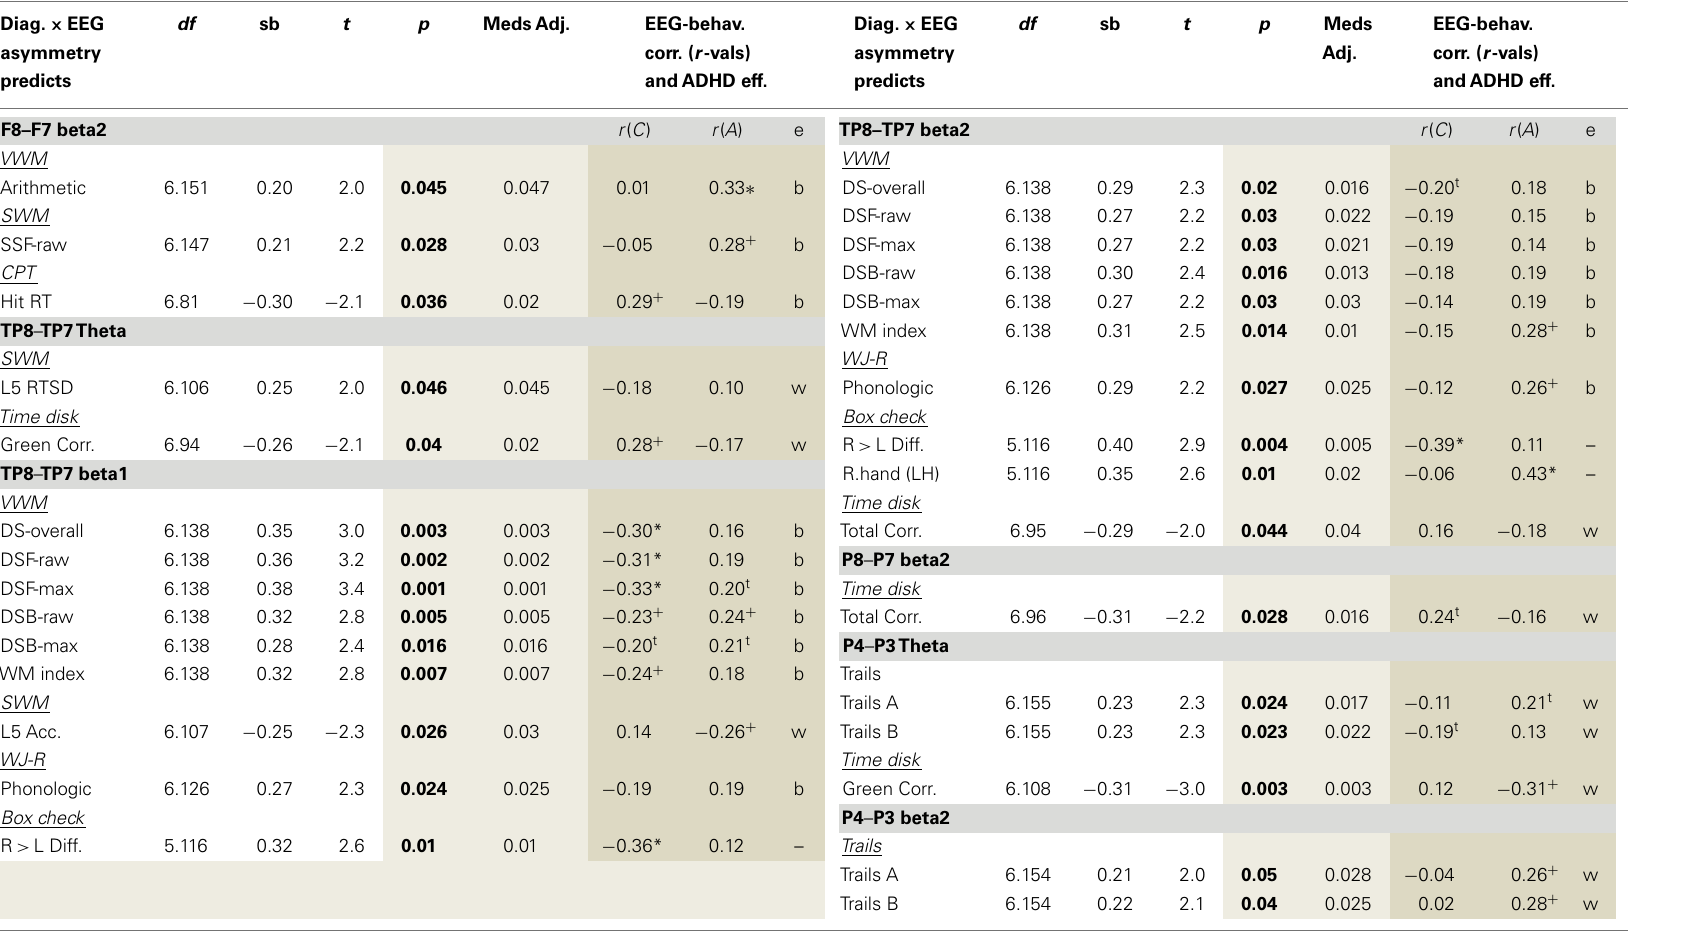
Table 9 | Parietal EEG asymmetry × ADHD status predicting cognitive abilities . Diag. × EEG asymmetry